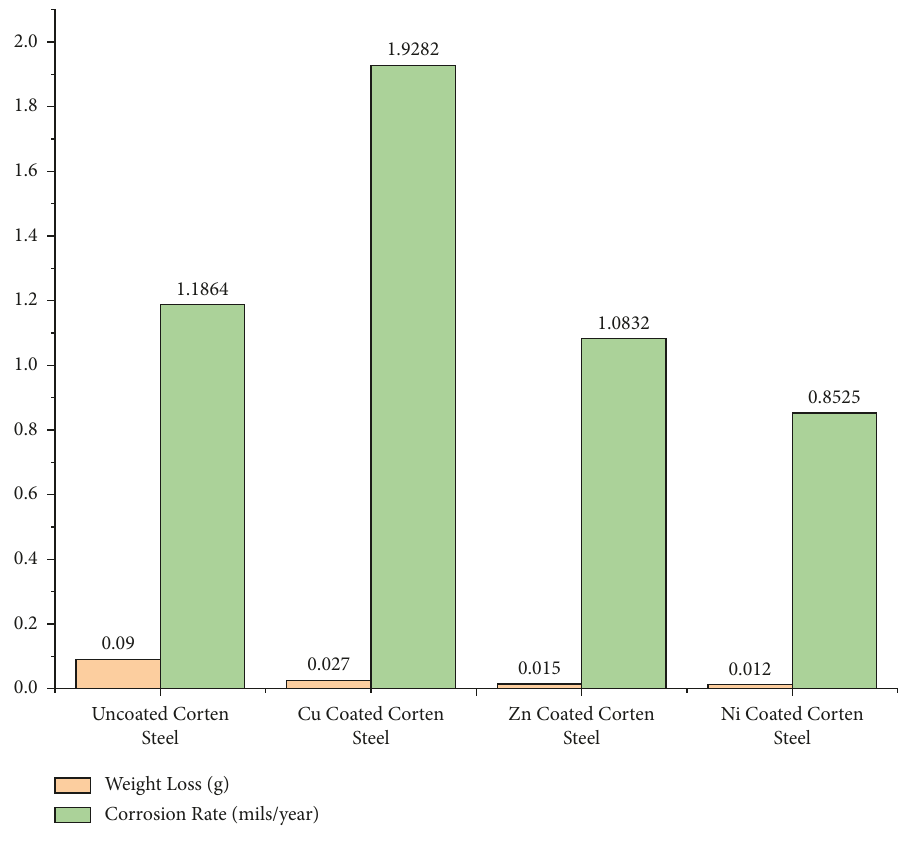
Figure 8: Salt spray test result of uncoated and coated corten steel.